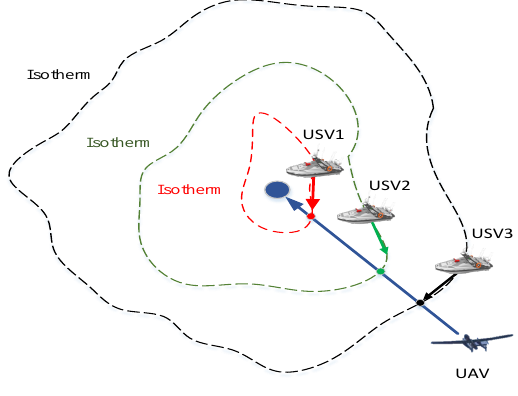
Figure 8. Heterogeneous cooperation between USVs and a